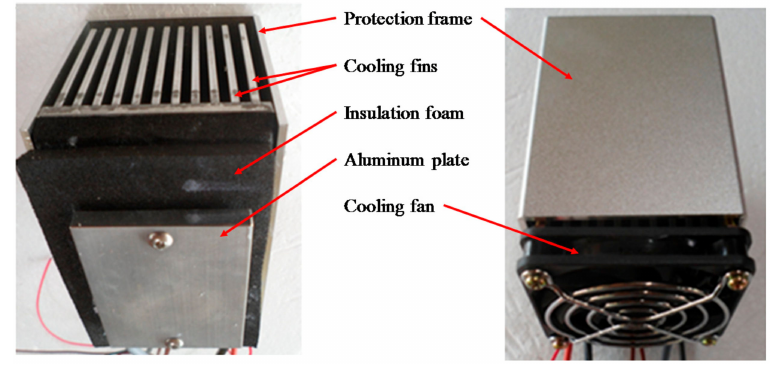
Figure 7. TEHS made for lab test based on the numerical